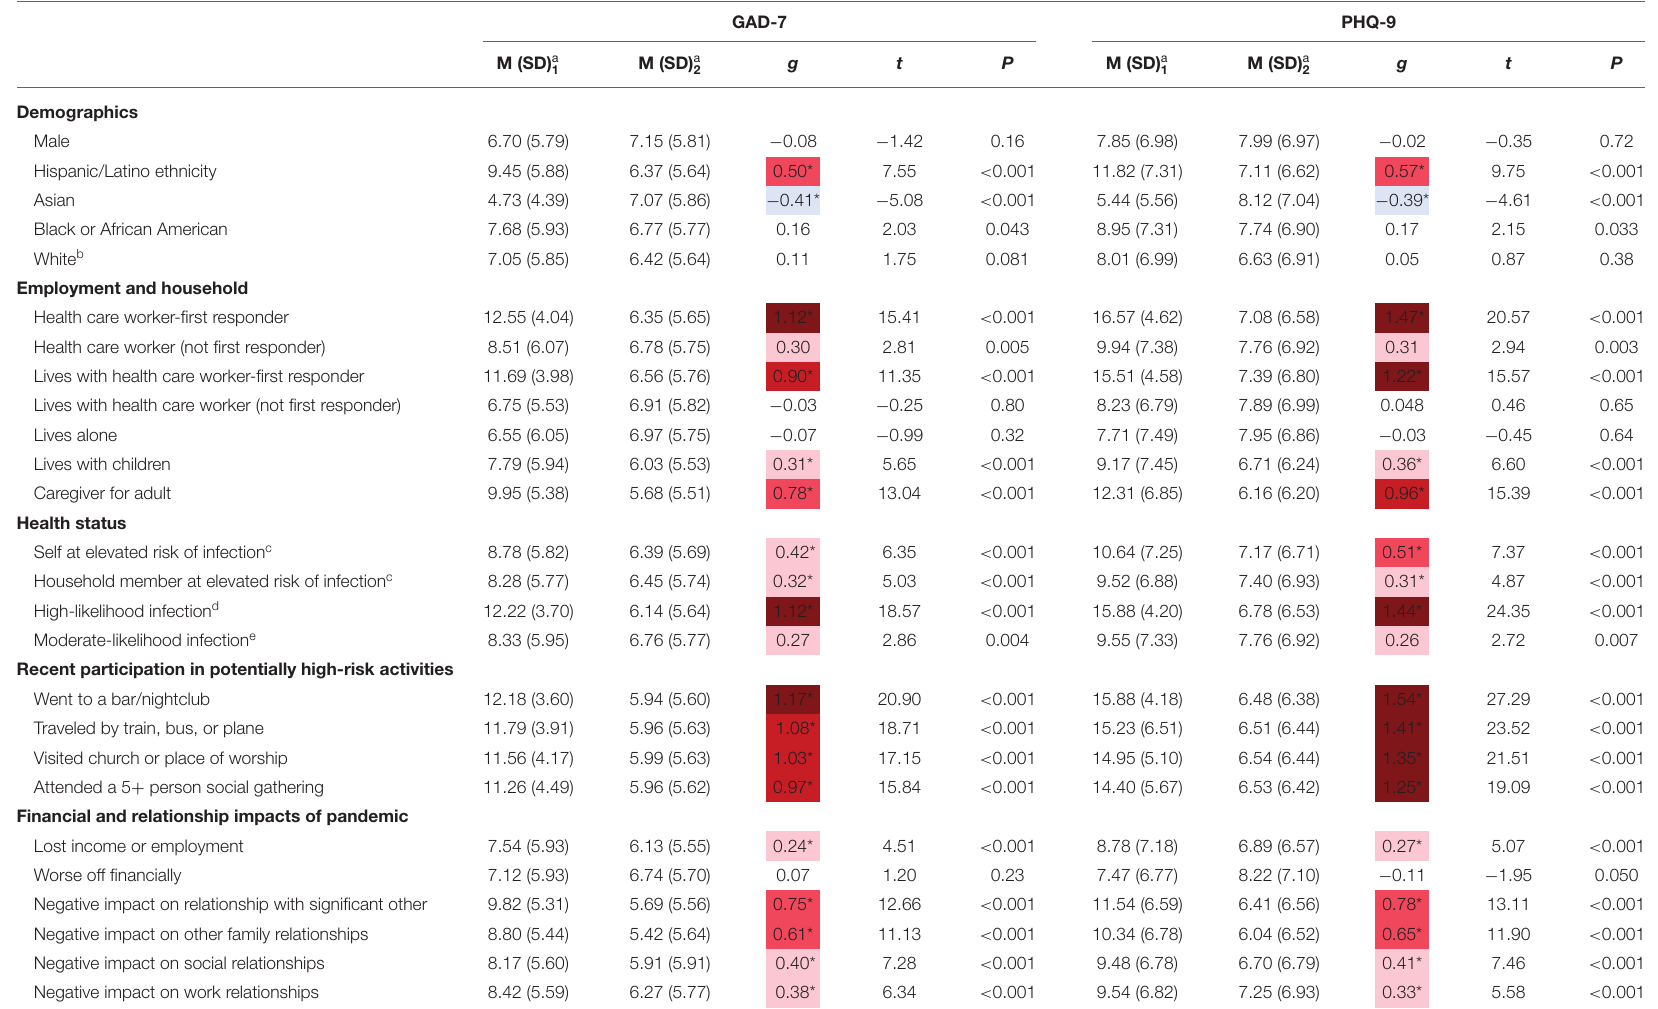
TABLE 2 | Univariate t -tests comparing generalized anxiety and depressive symptoms across subgroups. GAD-7